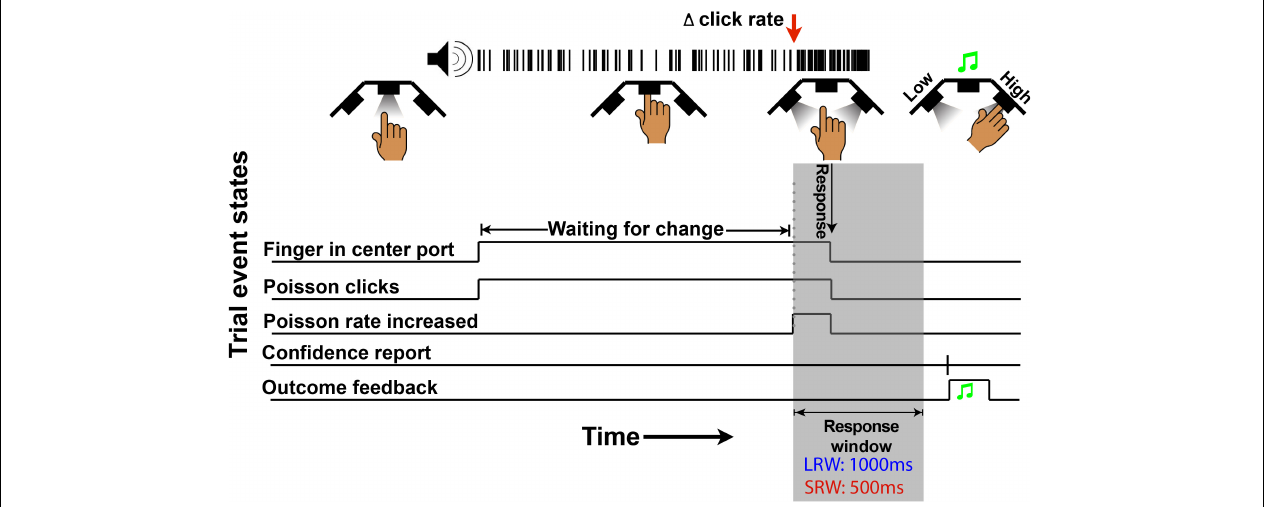
FIGURE 1 | Schematic of a change trial in the auditory change detection task. Trials begin with the LED “on” in the center port, instructing subjects to insert their finger. Thereafter, a series of stochastic auditory clicks generated by a 50 Hz Poisson process play, followed by an increase in the generative click rate at a random time (red arrow in this example). For a correct response, subjects must withdraw their finger from the port within the allotted response window (gray region – 1,000 ms in the LRW condition and 500 ms in the SRW condition). Lastly, subjects have to report their confidence in successfully completing the trial by poking the right port or left port to indicate high or low confidence, respectively. Auditory feedback was then provided to indicate if subjects were